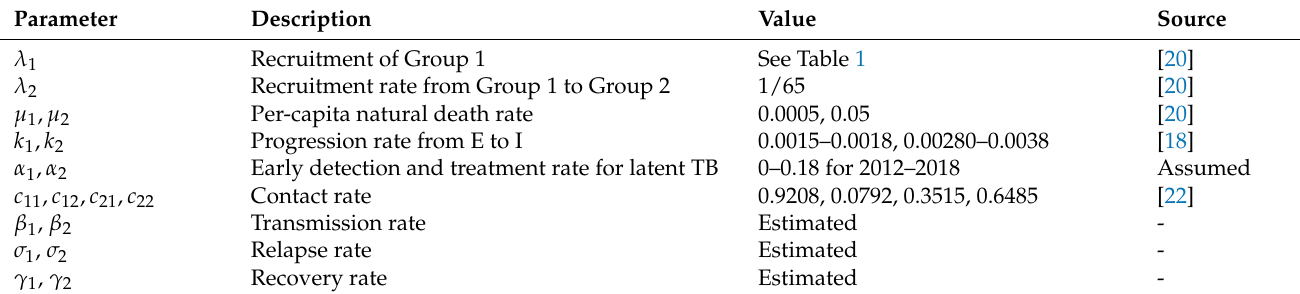
Table 4. Age-specific baseline parameters and descriptions are obtained from